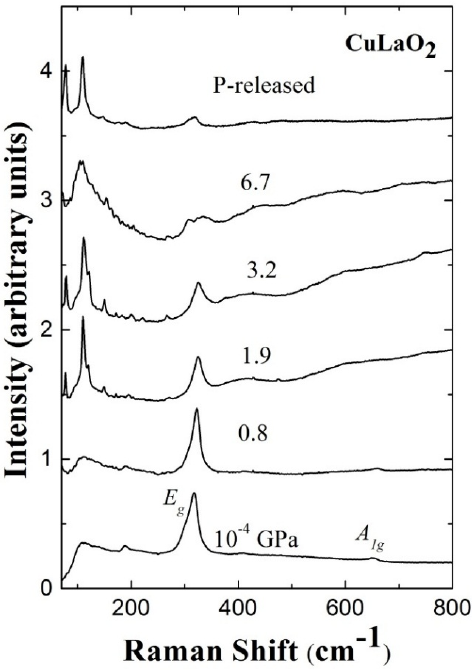
Figure 5. Raman spectra of CuLaO 2 at various pressures. Note the appearance of new modes above 2 GPa.